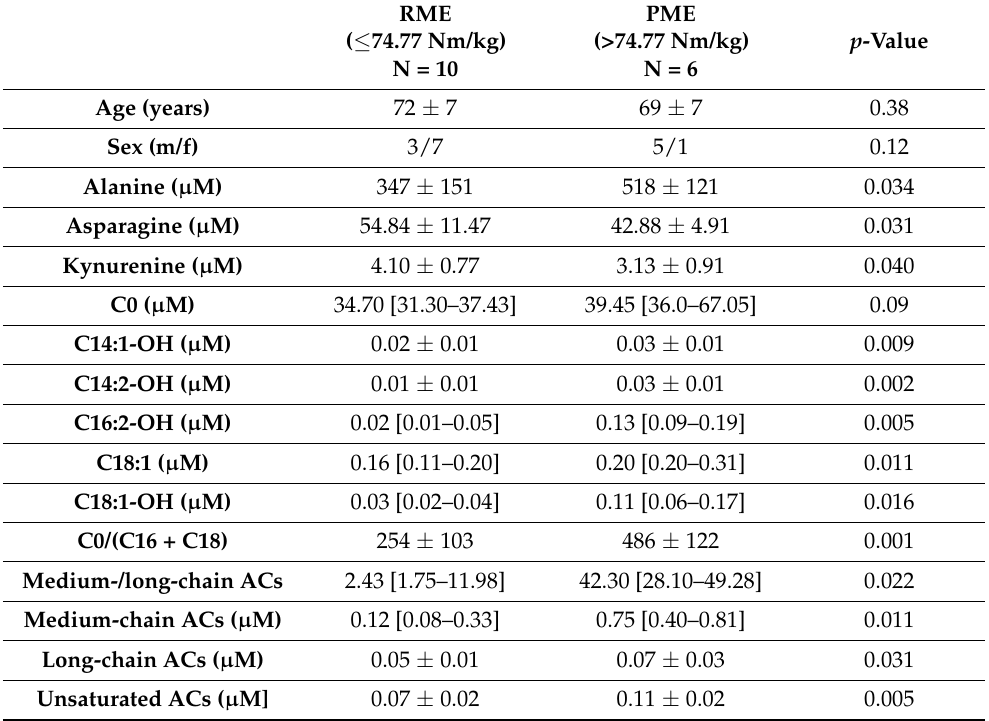
Table 3. Metabolomic profile of patients with HFpEF and RME vs. PME.